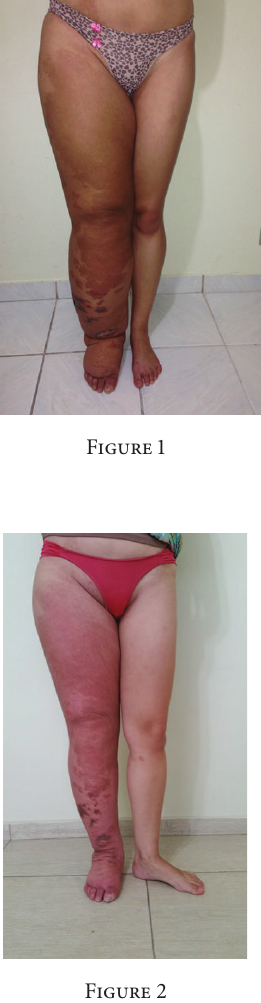
Therapy (Godoy & Godoy), Cervical Stimulation Therapy, Mechanical Lymphatic Therapy (RAGodoy), a grosgrain stocking adjusted several times daily, and an Unna’s boot in the region of the